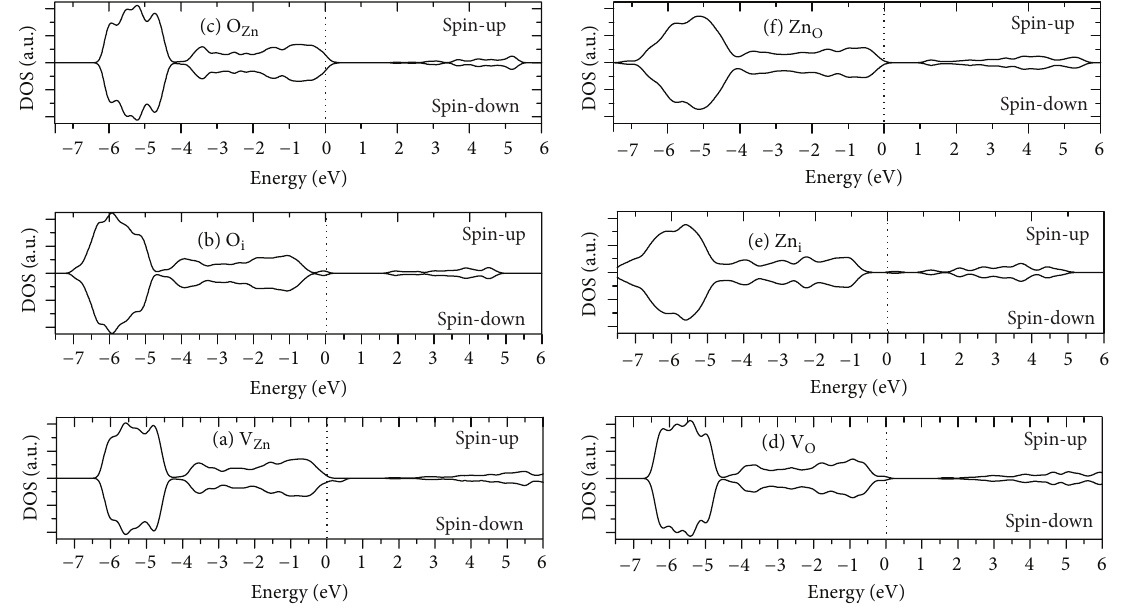
Figure 4: Calculated total DOS for ZnO nanowire with different intrinsic point